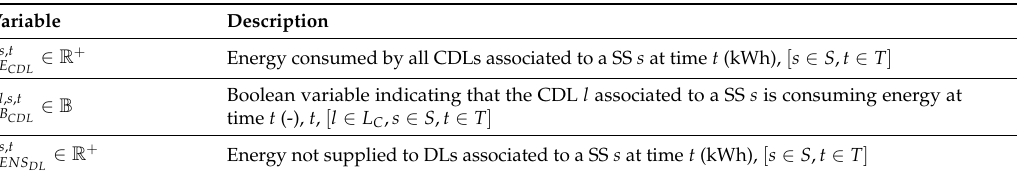
Table 8. Summary of variables (Demand-Side Management (DSM)